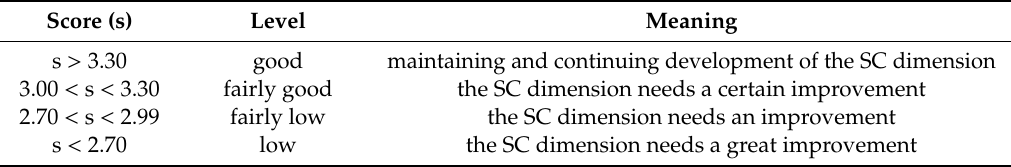
Table2. CriteriasuggestedbytheNationalResearchCentrefortheWorkingEnvironmentofDenmarkfor